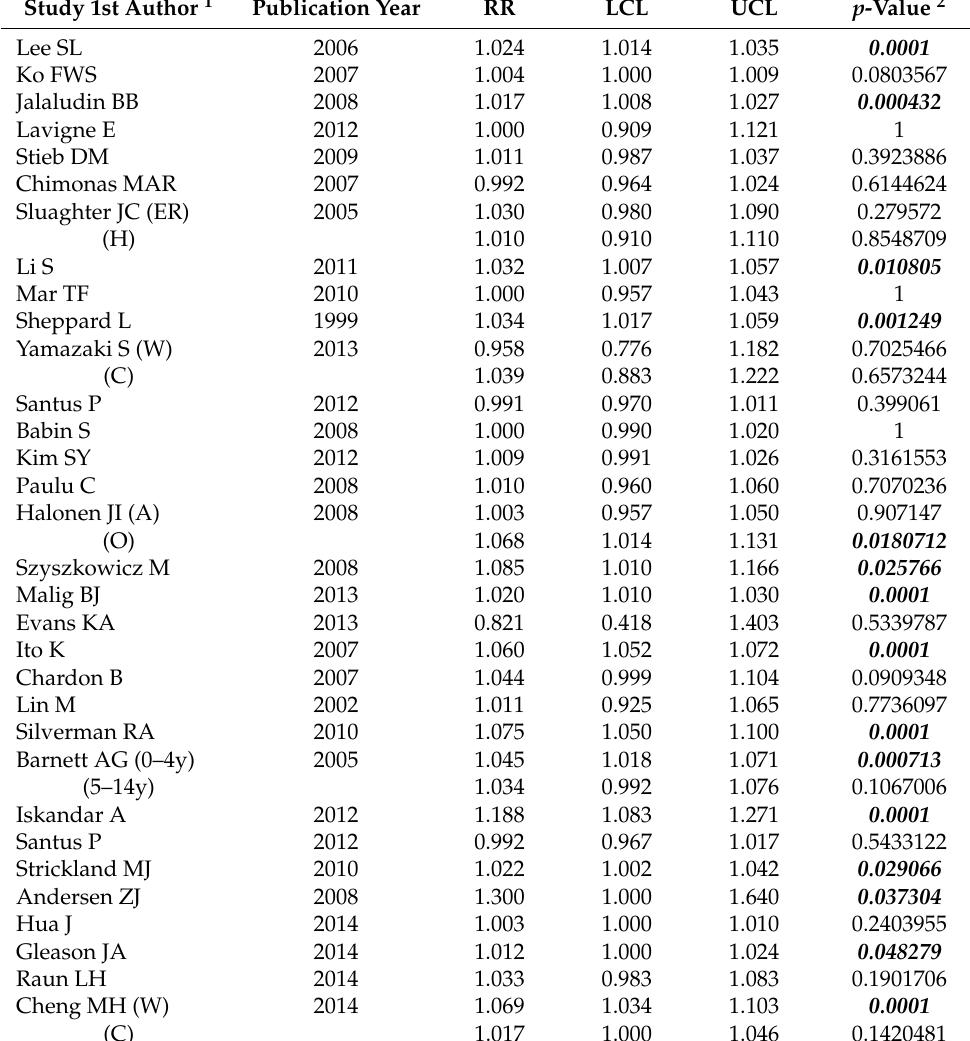
1 letters/numbers in brackets indicates results for different population subgroups from the same study. 2 bold, italicized p -value < 0.05 calculated after